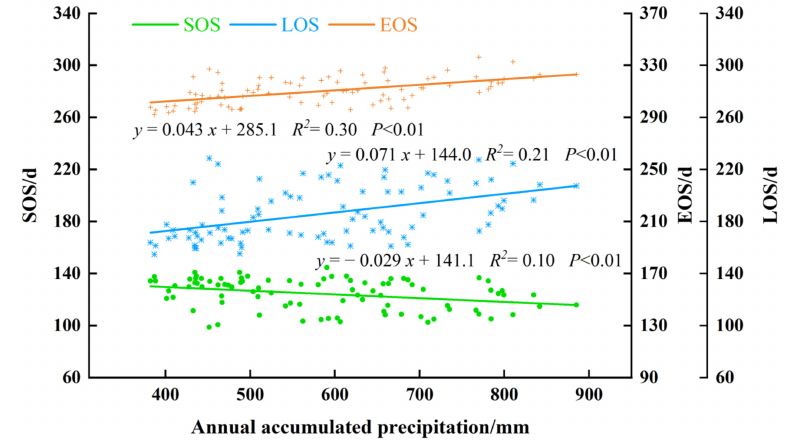
Figure 17. Response of Forest Phenology to Annual Cumulative Precipitation in northeast China from 2011 to 2020.